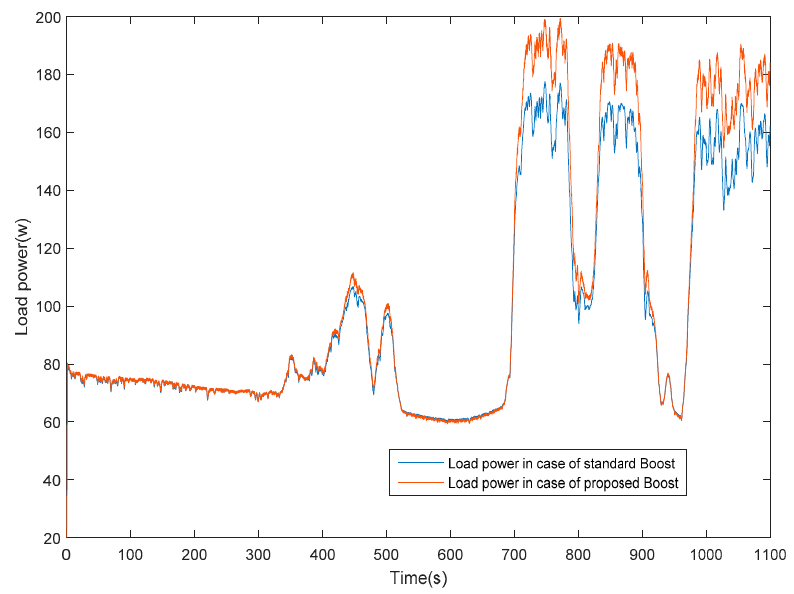
Figure 20. Measured power delivered to the load for the conventional and proposed converter.